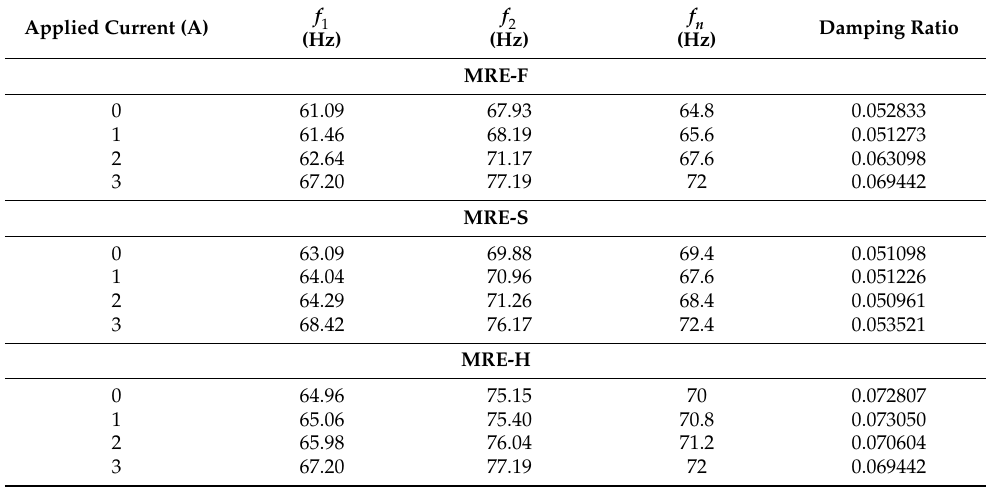
Figure 16. The percentage increase in the damping coefficient for MRE-F, MRE-S, and MRE-H. Table 5. The damping coefficients of MRE-F, MRE-S, and MRE-H at different current values.